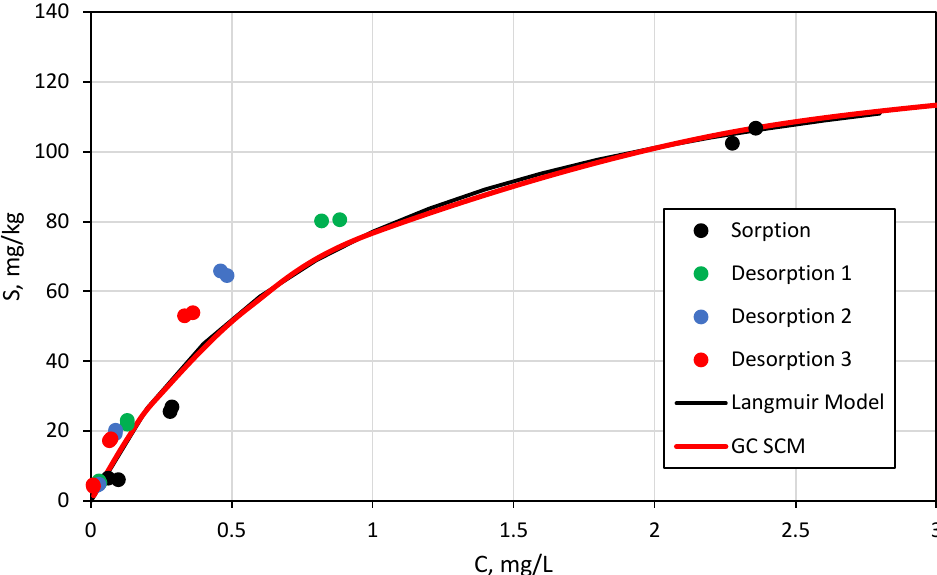
Figure 2. Sorption and desorption results for the OS-3 bituminous limestone marl. Green, blue, and red colored full circles represent results for desorption steps 1, 2, and 3, respectively. Black full circles represent the sorption data. Solid curves show GC SCM (red) and Langmuir isotherm (black) fits to the data.